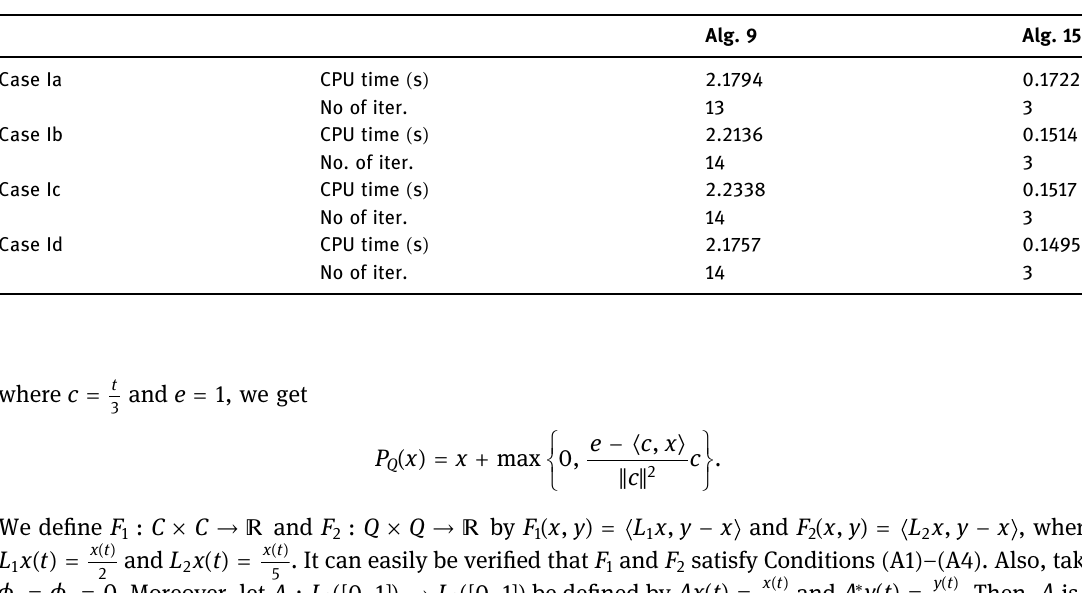
Figure 1: Top left: Case Ia; top right: Case Ib; bottom left: Case Ic; and bottom right: Case Id.